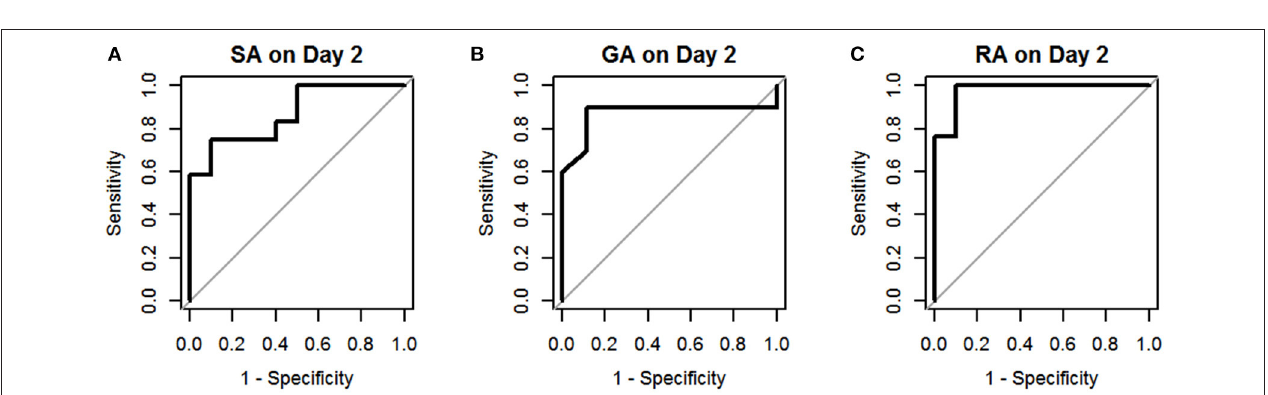
FIGURE 1 | Receiver operating characteristic curves for sCD40L in distinguishing children with acute appendicitis from NA on day 1: SA (A) , GA (B) , and RA (C) .